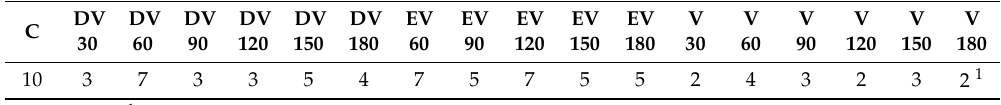
Table 4. Number of samples from cryopreservation treatments and untreated controls used in molecular